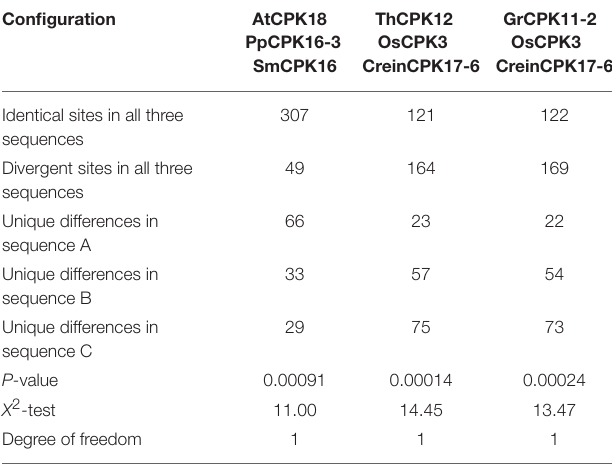
TABLE 4 | Results of Tajima’s test for 3 sequences in three replicate analyses.